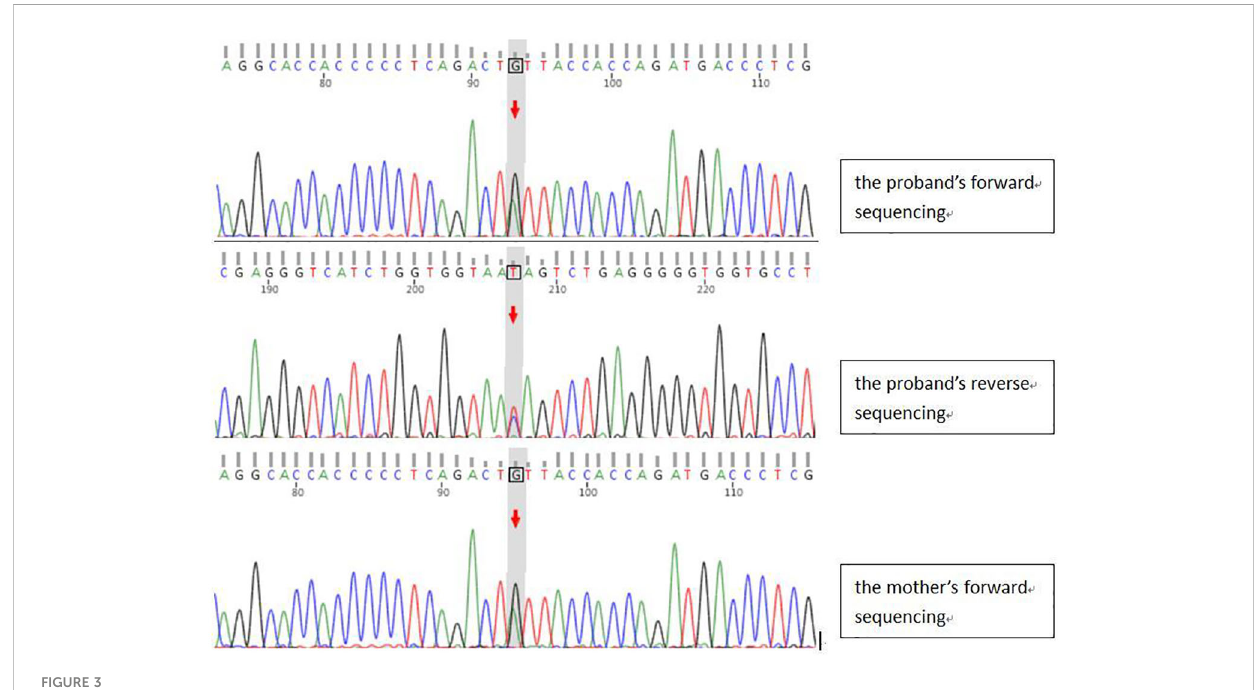
FIGURE 3 The peak map of gene